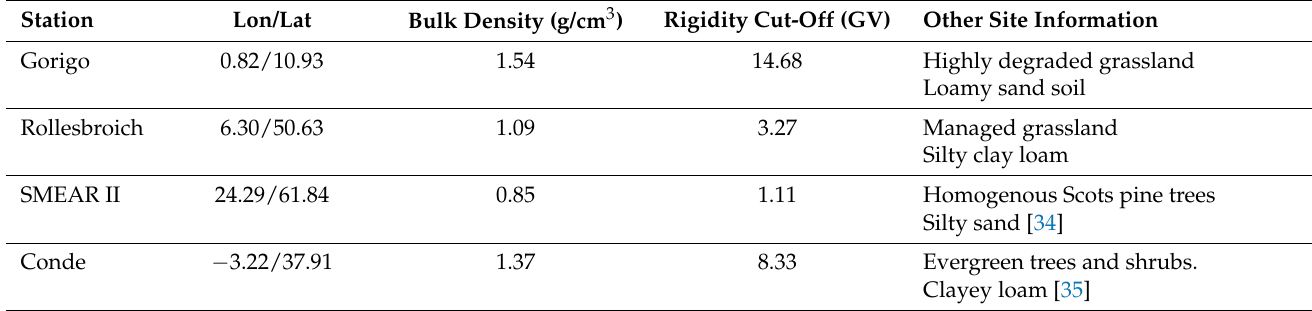
Table 1. Summary of the site